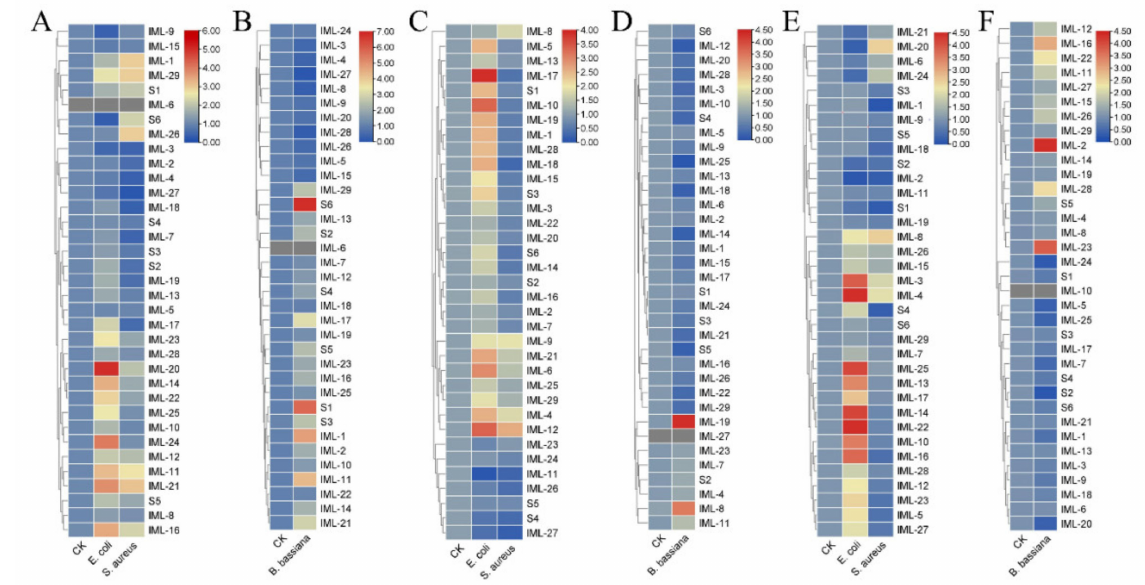
Figure 8. Expression of CTLs responding to E. coli , S. aureus , and B. bassiana conidia after 6 h. Formaldehyde-killed E. coli , S. aureus , and B. bassiana conidia were injected into fifth instar larvae. The expression of CTLs in hemocytes ( A , B ), fat body ( C , D ), and midgut ( E , F ) were analyzed by RT-qPCR. Values (log2) representing the relative expression levels were directly mapped to the color scale without normalization. Dendrograms were generated by the hierarchical clustering analysis of rows.